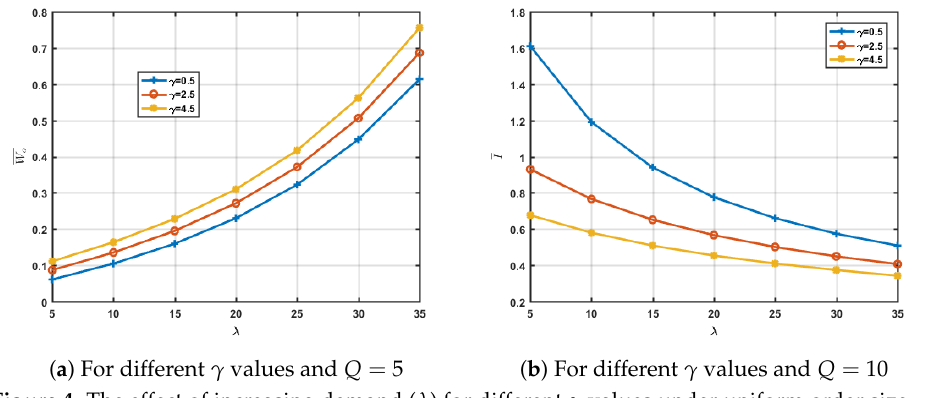
Figure 4. The effect of increasing demand ( λ ) for different γ values under uniform order